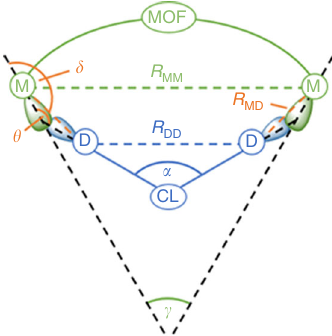
Fig. 2 Geometric parameters of a general CL@MOF system. The parameters R MM and γ are determined by the spatial arrangements of the OMSs of the parent MOF (green), while R DD and α are given by the CL (blue). θ is computed from α and γ , whereas the parameters R MD and δ (orange) are variables and optimized with respect to the underlying